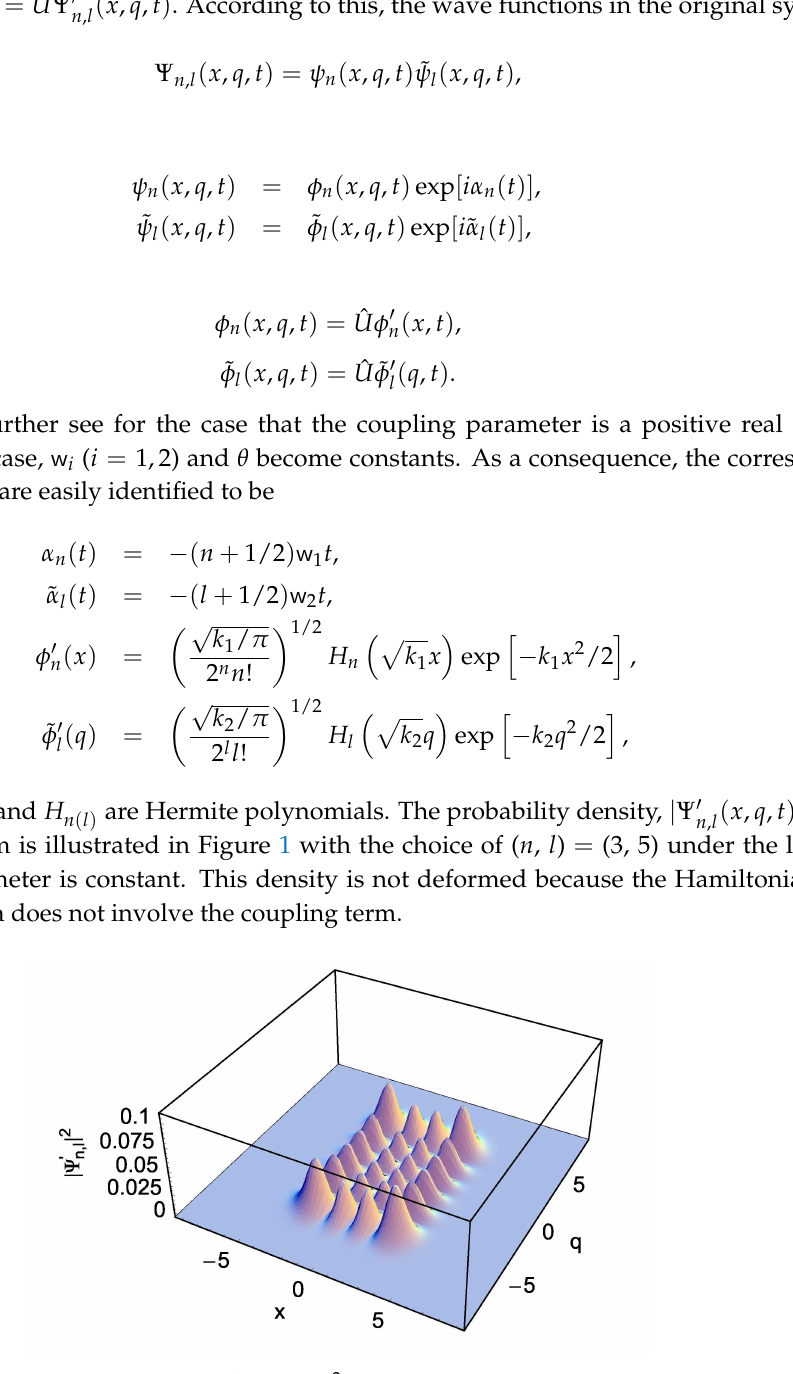
( x , q , t ) | 2 , in the transformed system with the choice of Figure 1. The probability density, | Ψ (cid:48) n , l ( m , L ) = (1.0, 1.0) under the limit λ ( t ) = λ 0 . This is associated to the wave functions, Equation (18) with Equations (15), (16), and (24)–(27). We used ( n , l ) = (3, 5), ( ω , Ω ) = (0.5, 0.49), ¯ h = 1, and λ 0 =